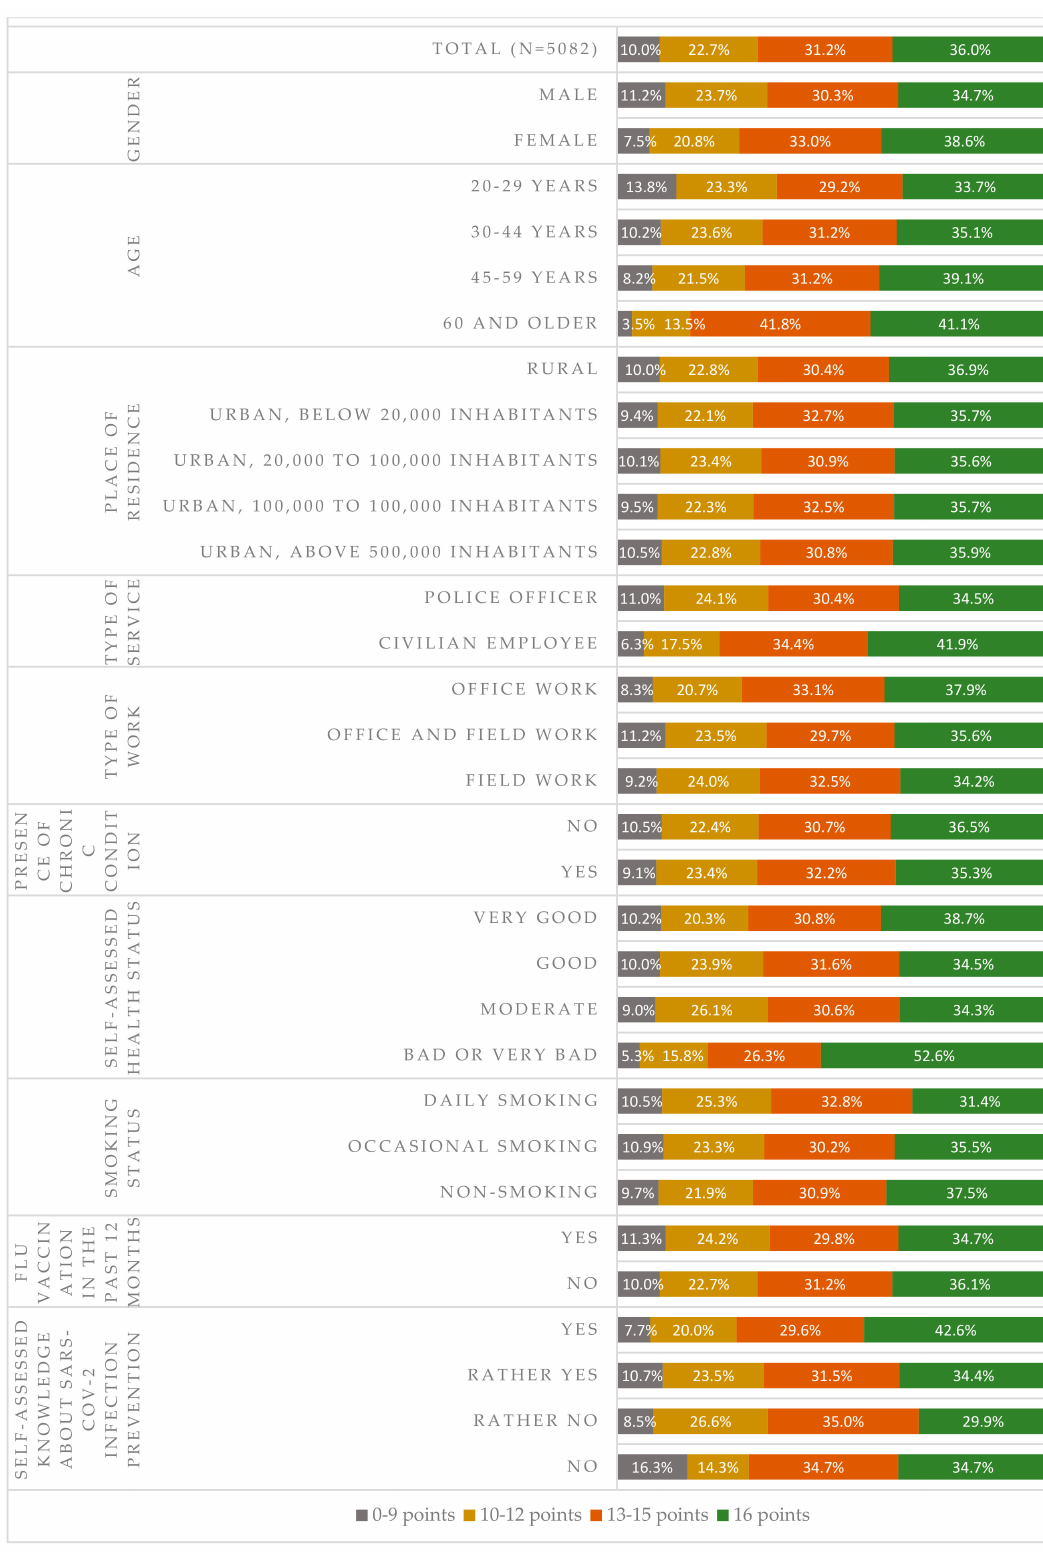
Figure 2. Compliance with the preventive measures aimed at reducing the SARS-CoV-2 infection risk (scale of 0 to 16—the higher the score, the better compliance with recommendations) depending on selected sociodemographic